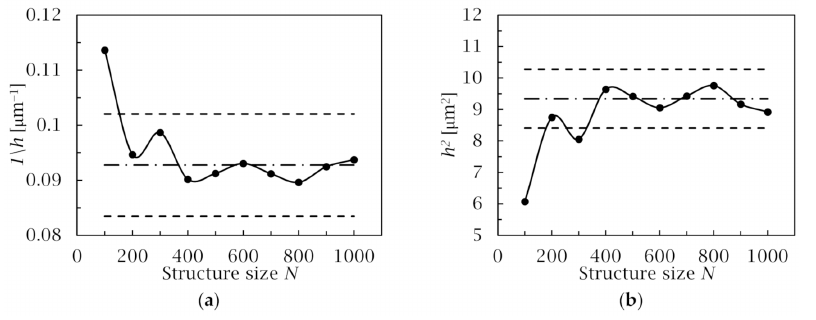
Figure 15. Results of ( a ) 1/ h and ( b ) h 2 change with resolution. h = 1/ s , is reciprocal of specific area and represents average pore size. Long-dashed line is the estimated mean value and two short-dashed lines cover 10% variation of the mean